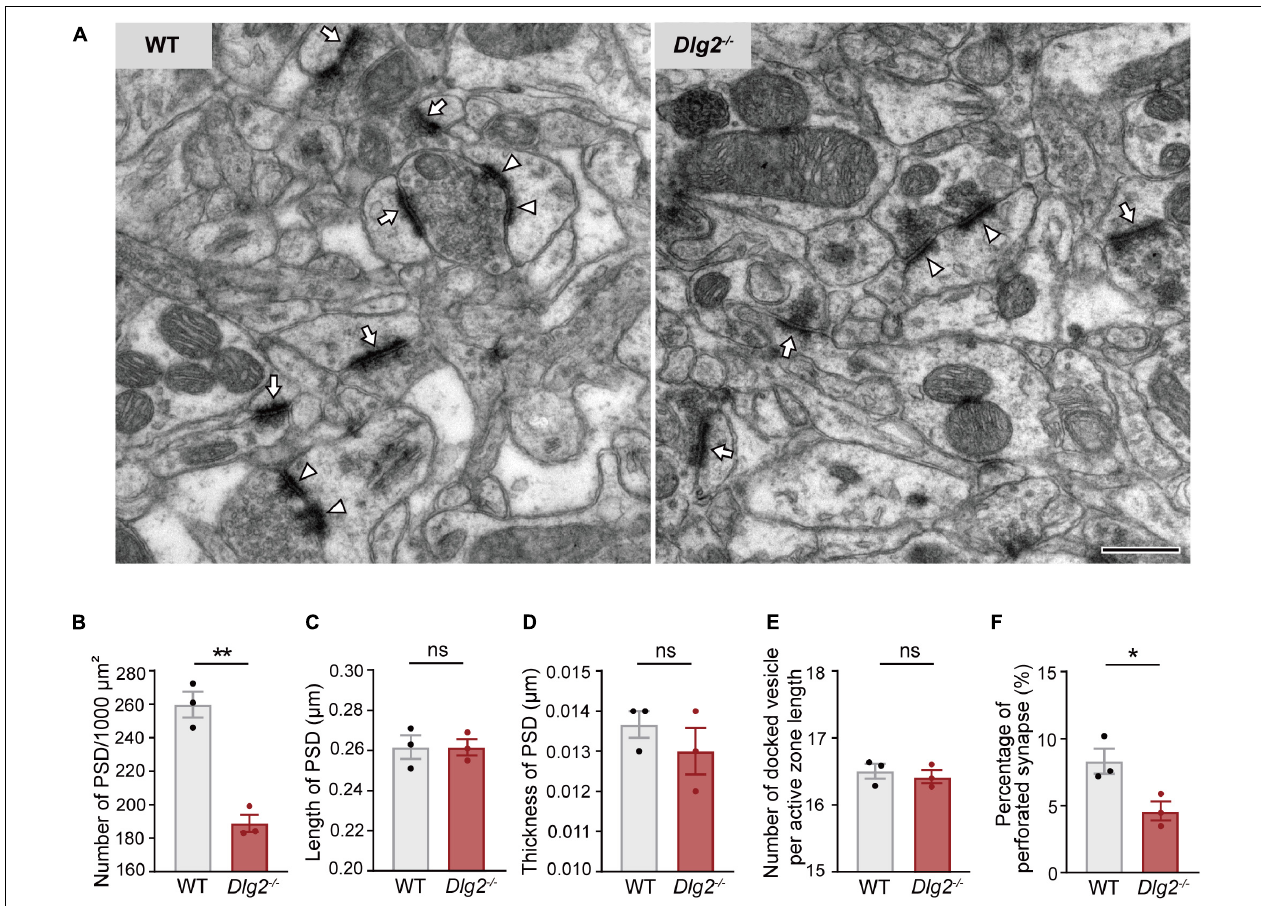
FIGURE 2 | The number of functional synapses is decreased in the dorsolateral striatum of Dlg2 -/- mice. (A) Representative electron microscopy images of the dorsolateral striatum of WT and Dlg2 -/- mice. Arrows, synapse; arrowheads, perforated synapse. Scale bar, 500 nm. (B) The number of PSDs in the dorsolateral striatum was significantly reduced in Dlg2 -/- mice, corroborating the decreased number of synapses in the dorsolateral striatum. (C–E) There were no group differences in the length or thickness of PSDs or the number of presynaptic docked vesicles per active zone length. (F) The percentage of perforated synapses was significantly reduced in Dlg2 -/- mice. A total of 32 micrographs per animal were analyzed (WT, n = 3 mice; Dlg2 -/- , n = 3 mice). * p < 0.05; ** p < 0.01; ns, not significant. Student’s t